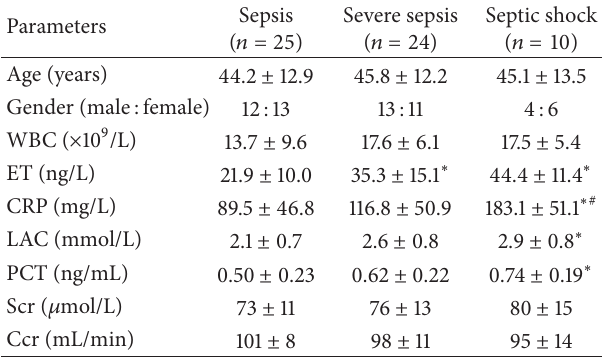
Table 3: Parameters of uroseptic patients depending on the disease severity after